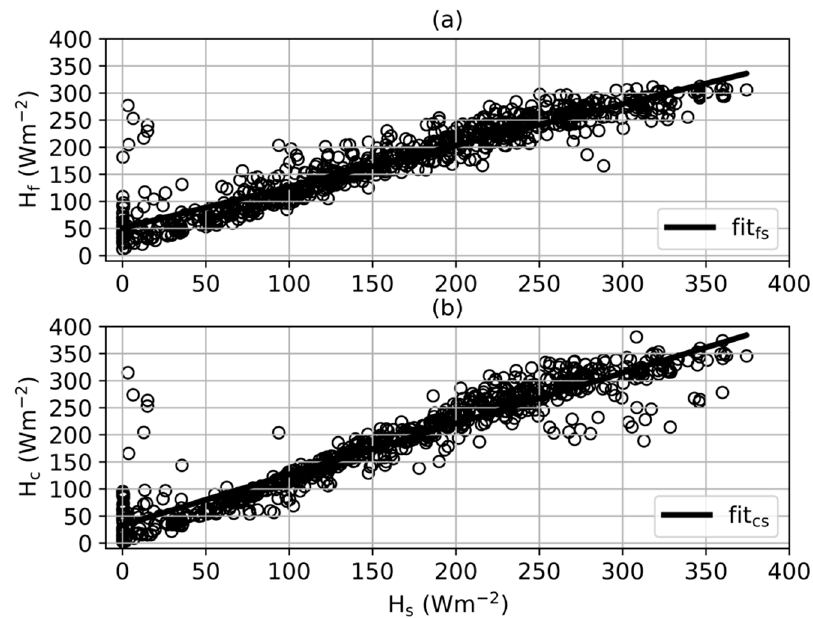
Figure 4. Scatter plots of ( a ) H s vs. H f and ( b ) H c vs. H f , fitted are also shown in each sub-figure.